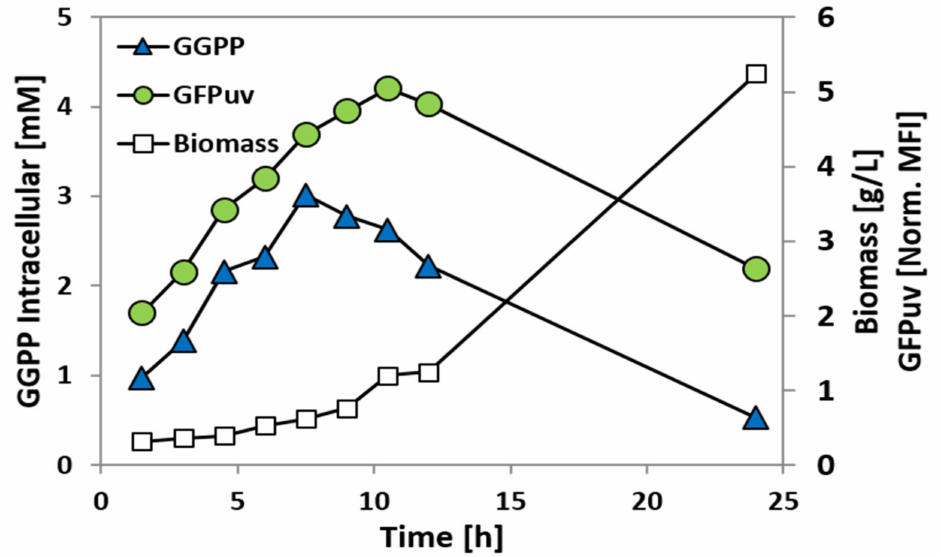
Figure 7. GGPP concentration and GFPuv fluorescence during growth of GGPP accumulating C. glutamicum strain GGPPB (pEPR1_P crtE ). Intracellular GGPP concentration (blue triangles; in mM) and GFPuv signal (green circles; mean fluorescence intensities normalized to autofluorescence) were monitored during growth in CGXII (100 mM Gluc + 100 µ M IPTG). Biomass concentrations are given in gCDW / L (empty